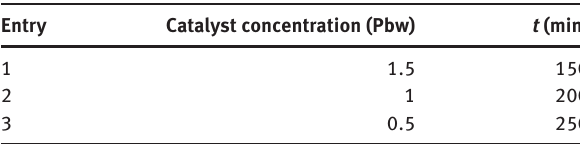
Table 3: Catalyst concentration role using nano-TiO support in chemical recycling of PC wastes.